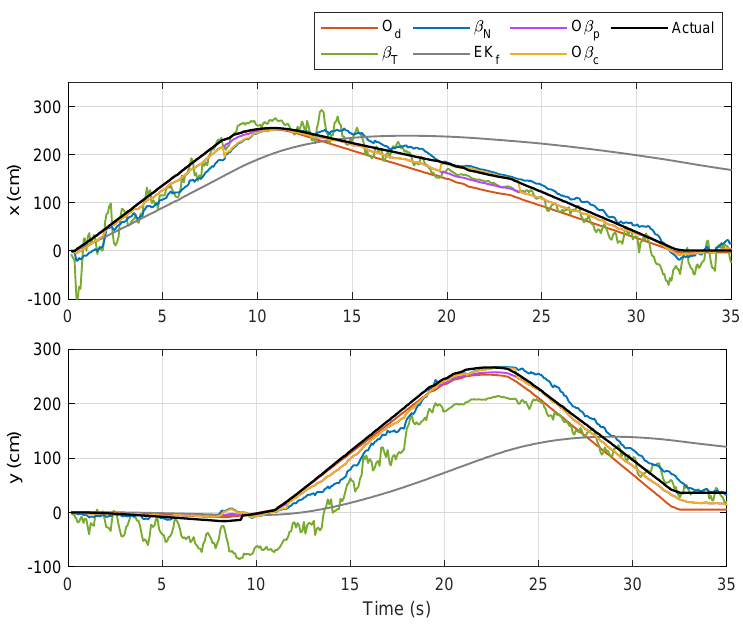
Figure 13. Localization of Node M in xy -plane in Trajectory 2.